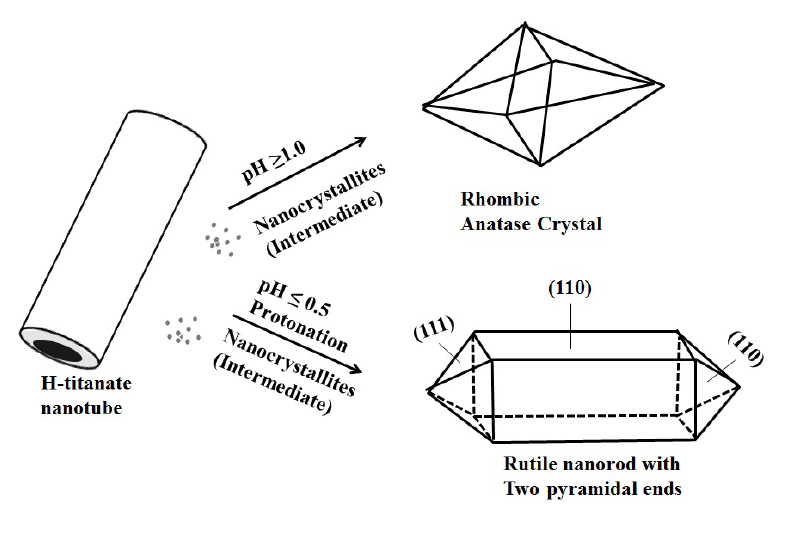
Figure 3. Schematic diagram for the mechanism of hydrothermal transformation from H-titanate nanotubes into single-crystalline TiO nanomaterial with different phase composition and morphology